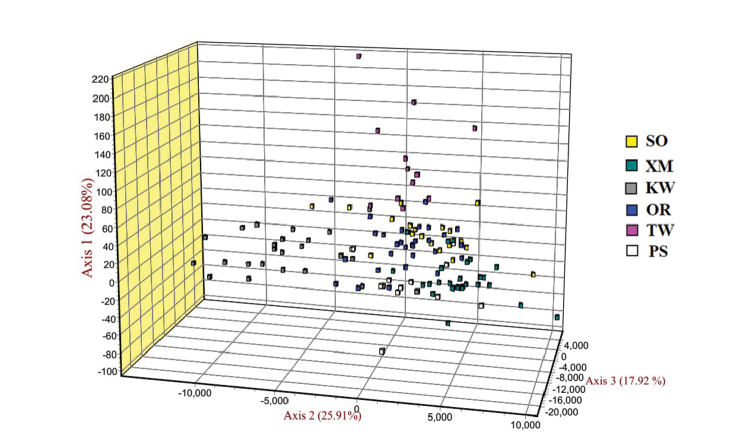
3D-FCA showing relationships among six populations of P.argenteus based on seven microsatellite loci. Abbreviations: SO: Sonmiani Bay, OR: Ormara, PS: Pasni, KW: Kuwait, TW: Taiwan, XM: Xiamen.